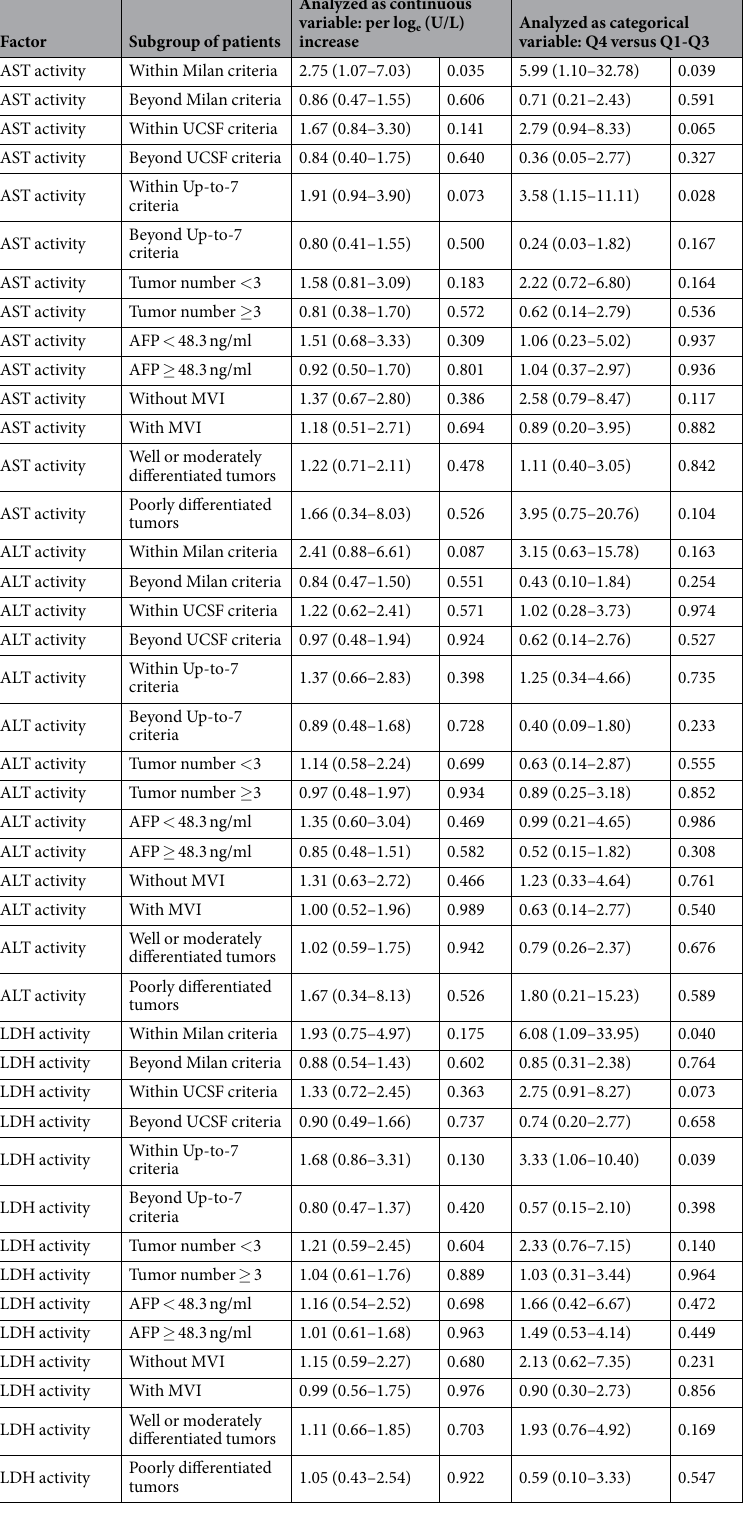
Table 6. Subgroup analyses of the associations between post-reperfusion aspartate transaminase, alanine transaminase, and lactate dehydrogenase activity and the risk of hepatocellular carcinoma recurrence after liver transplantation according to fulfillment of selection criteria and independent risk factors. Q4 – fourth quartile; Q1-Q3 – first to third quartile; AST – aspartate transaminase; ALT – alanine transaminase; LDH –